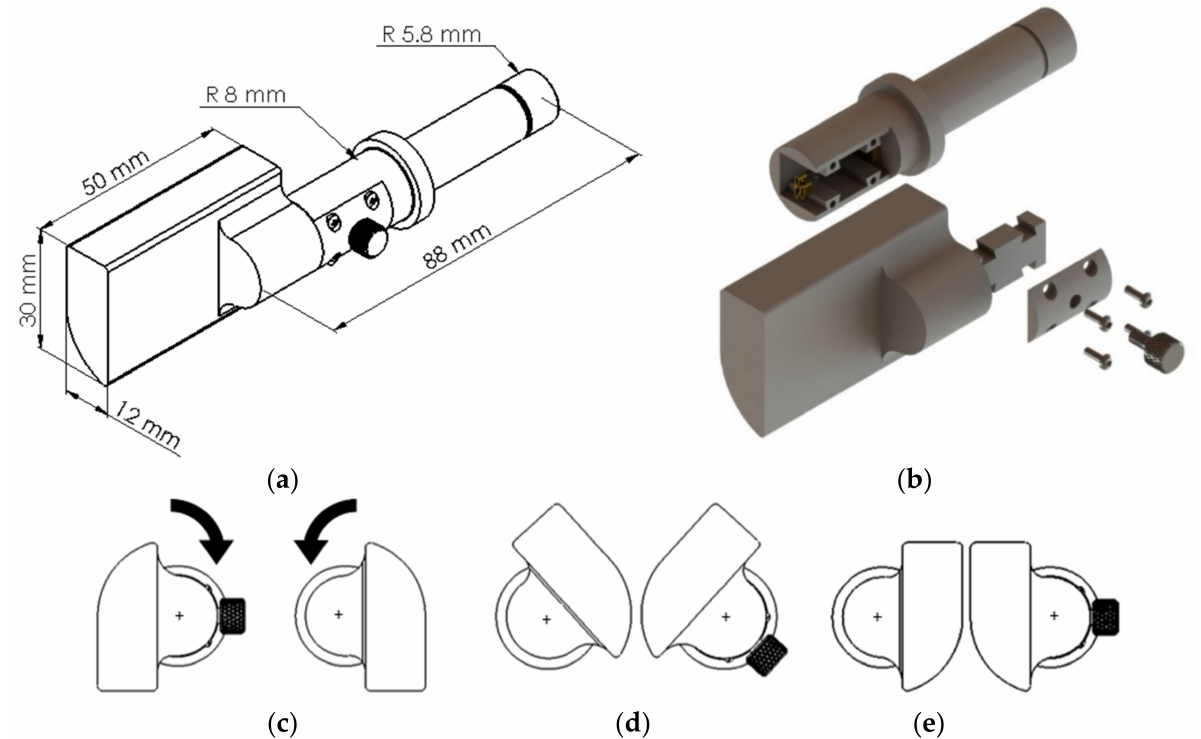
Figure 3. Grasping elements architecture: ( a ) main sizes; ( b ) regulation system exploded view; ( c ) open configuration with indication of fingers rotation directions; ( d ) intermediate configuration; ( e ) fully closed